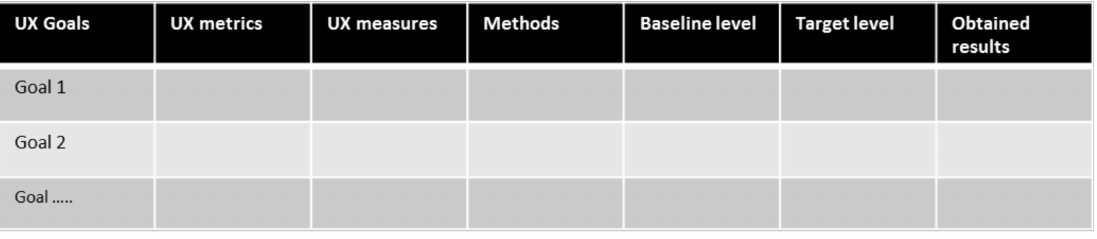
Figure 5. Evaluation matrix (adapted from